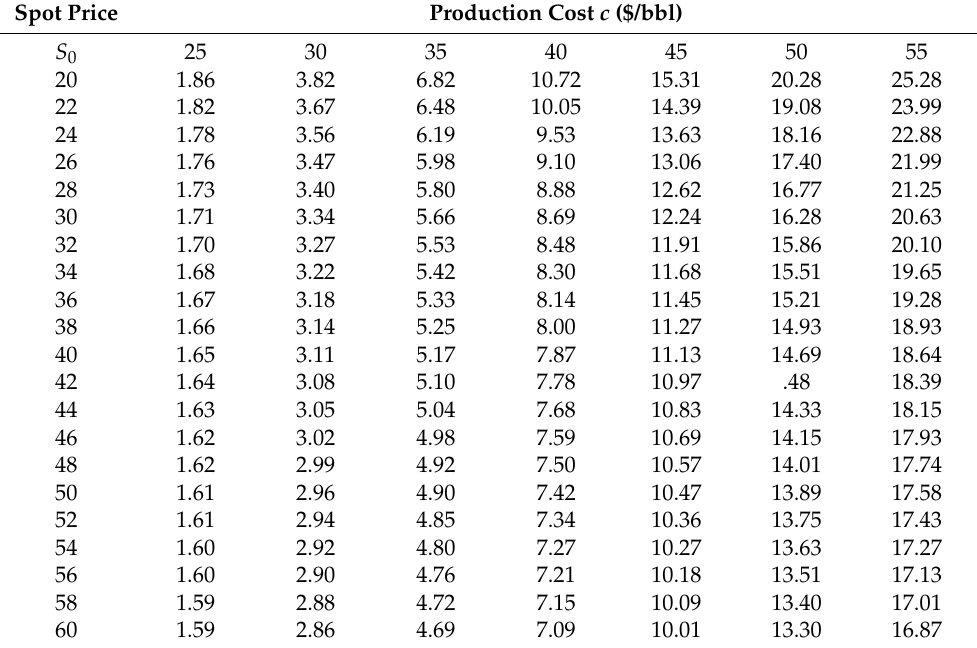
Table 4. Value of 5-year option to abandon a 10-year well when S ∗ Spot